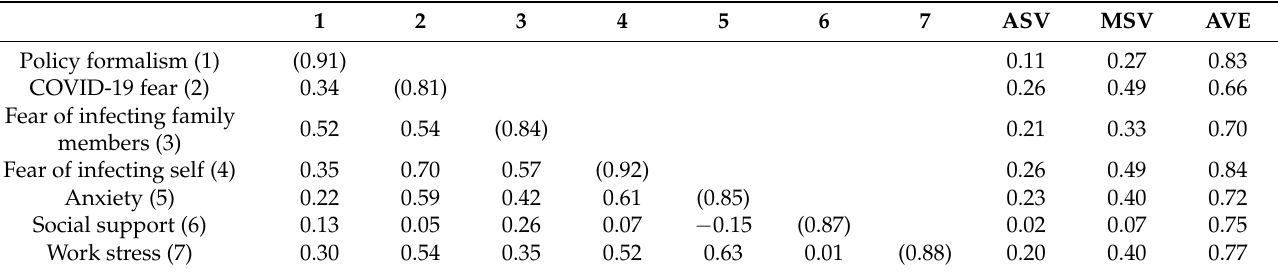
Table 3. Square root of AVE and intercorrelations.